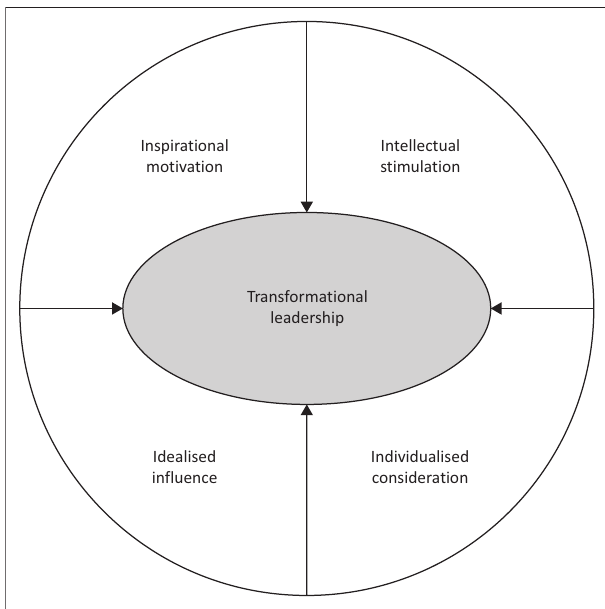
FIGURE 1: Transformational